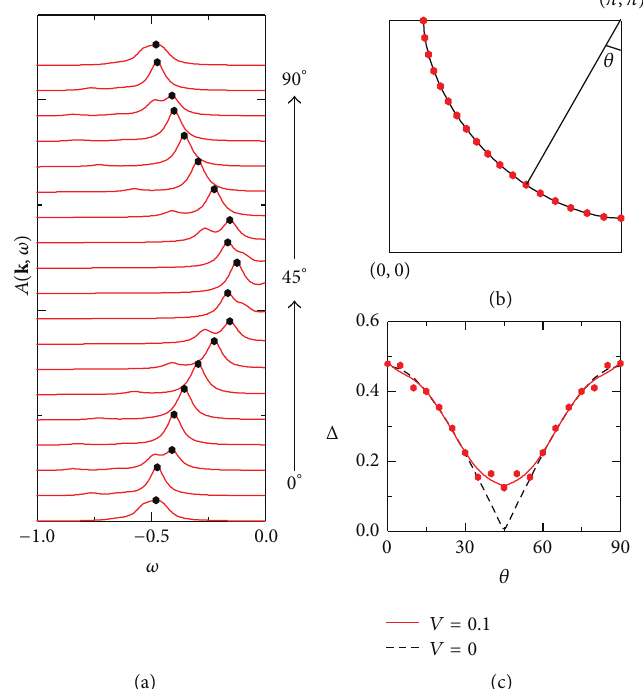
Figure 2: (a) The energy dependence of the spectral functions for different Fermi angle 𝜃 , with the points and the Fermi angle being shown in (b). (c) The energy gap as a function of the Fermi angle. The closed circles are the energy gap obtained from (a). The red solid line is a polynomial fitting for the data. The dashed line is the 𝑑 -wave superconducting gap magnitude.